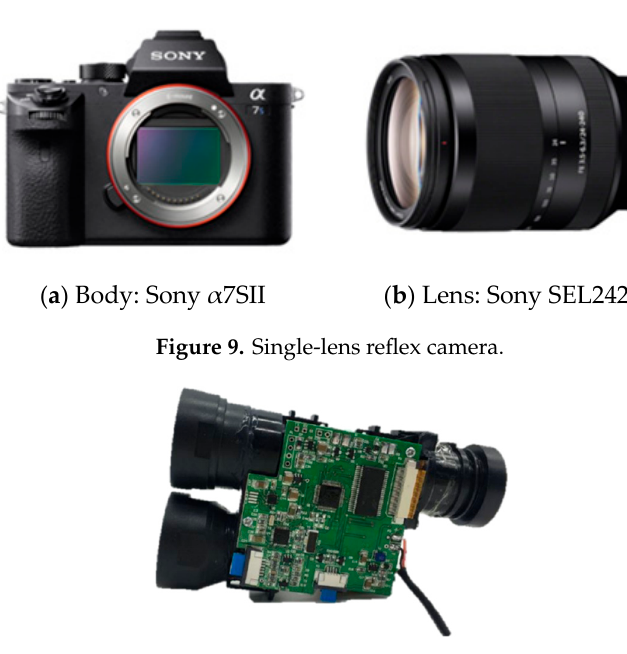
Appl. Sci. 2019 , 9 , x FOR PEER REVIEW Figure 8. TE–EQ1 infrared thermal imaging device. Figure 8. TE–EQ1 infrared thermal imaging device.